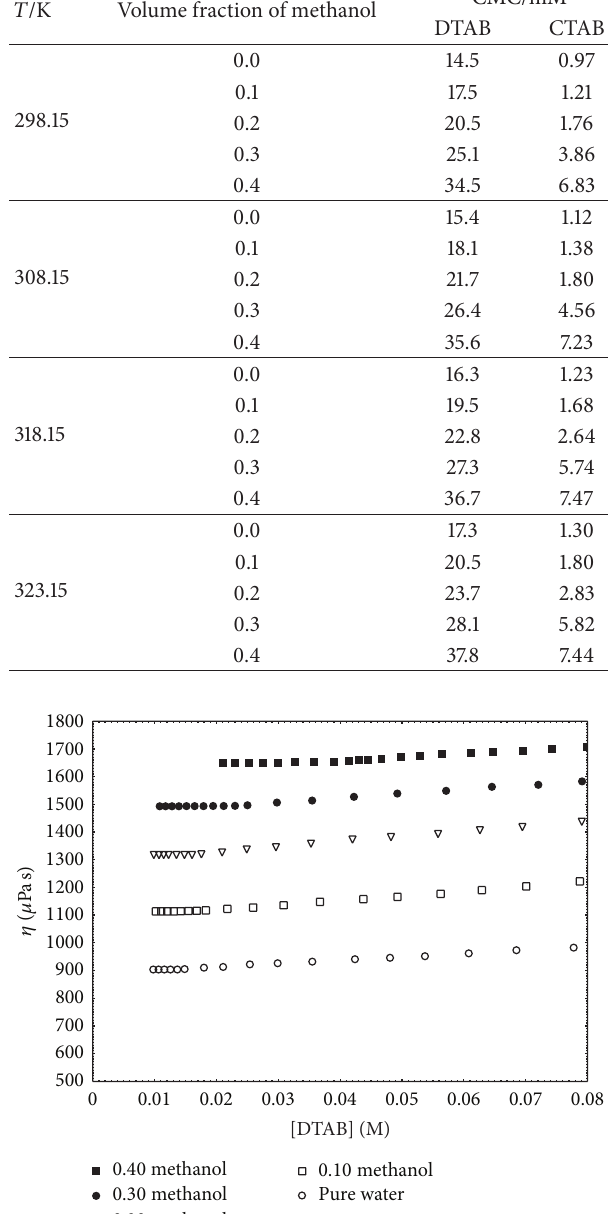
Table 2: CMC values of dodecyltrimethylammonium bromide (DTAB) and cetyltrimethylammonium bromide (CTAB) in water and 0.10, 0.20, 0.30, and 0.40 volume fractions of methanol-water at 298.15 K, 308.15 K, 318.15 K, and 323.15 K.